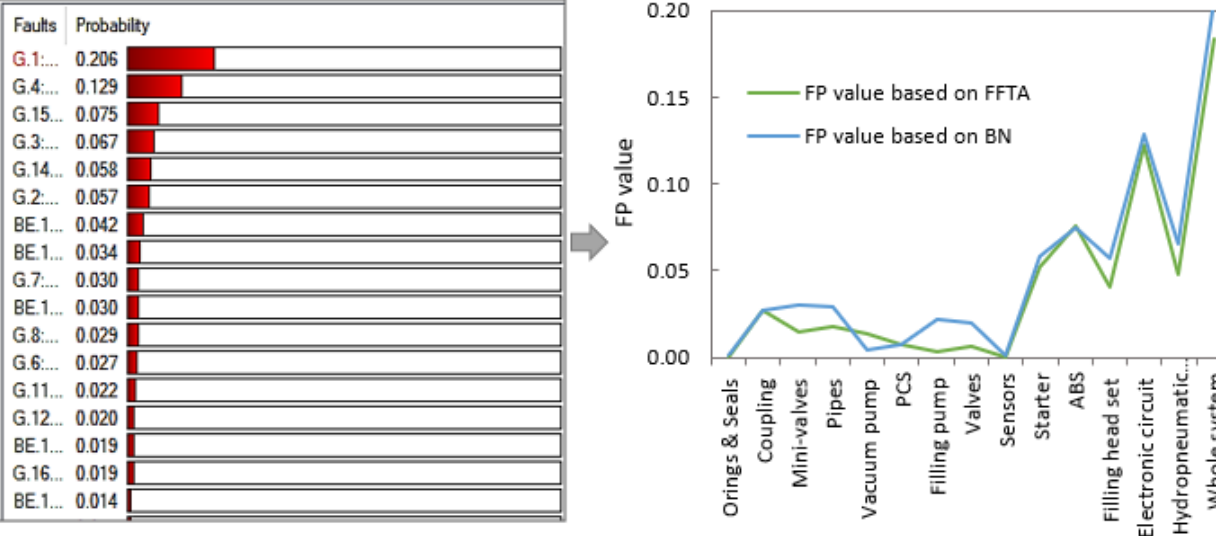
Figure 8. The conditional probability process of intermediate nodes based on logic gates in GeNIe 3.0 software.